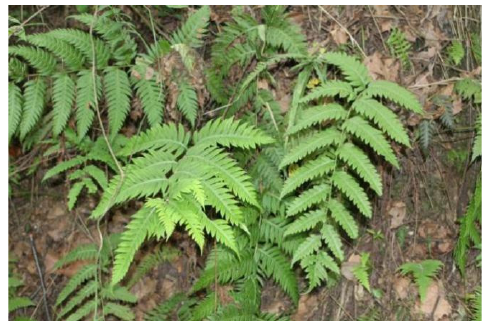
Figure 11. Morphological characteristics of W. japonica.